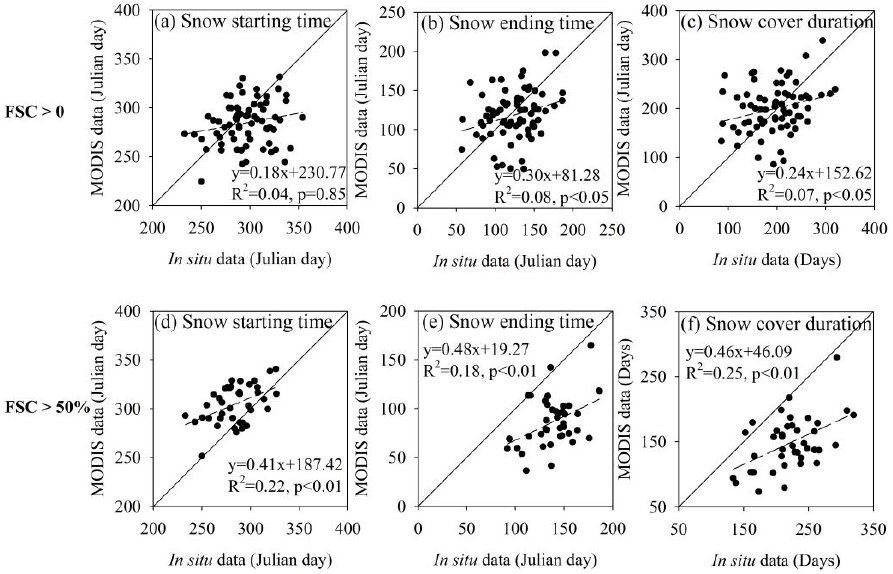
Figure 8. The relationship between the in situ data and MODIS data in the snow starting time, the snow ending time, and the snow-cover duration on both the threshold of FSC >0 (71 sites available) and FSC >50% (40 sites available).